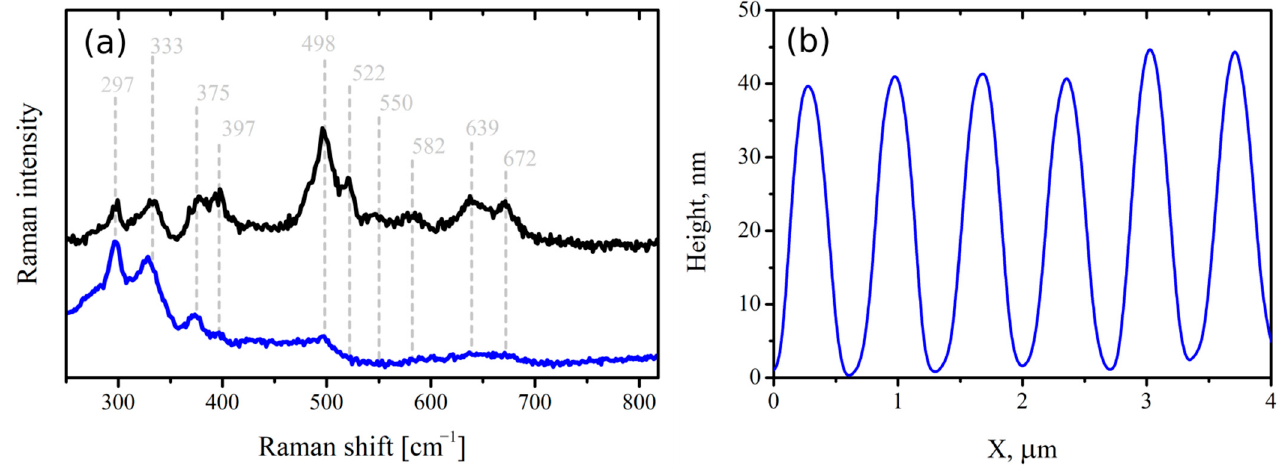
Figure 5. ( a ) Raman spectra of TLIPSS structures. The black line is the spectrum measured from TLIPSS formed on thick (150 nm) coating. The blue line corresponds to TLIPSS formed on 15 nm thick coating at 250 mW and 2000 μ m/s. Spectra vertically shifted for clarity. ( b ) AFM profile of TLIPSS formed at 250 mW and 2000 μ m/s.